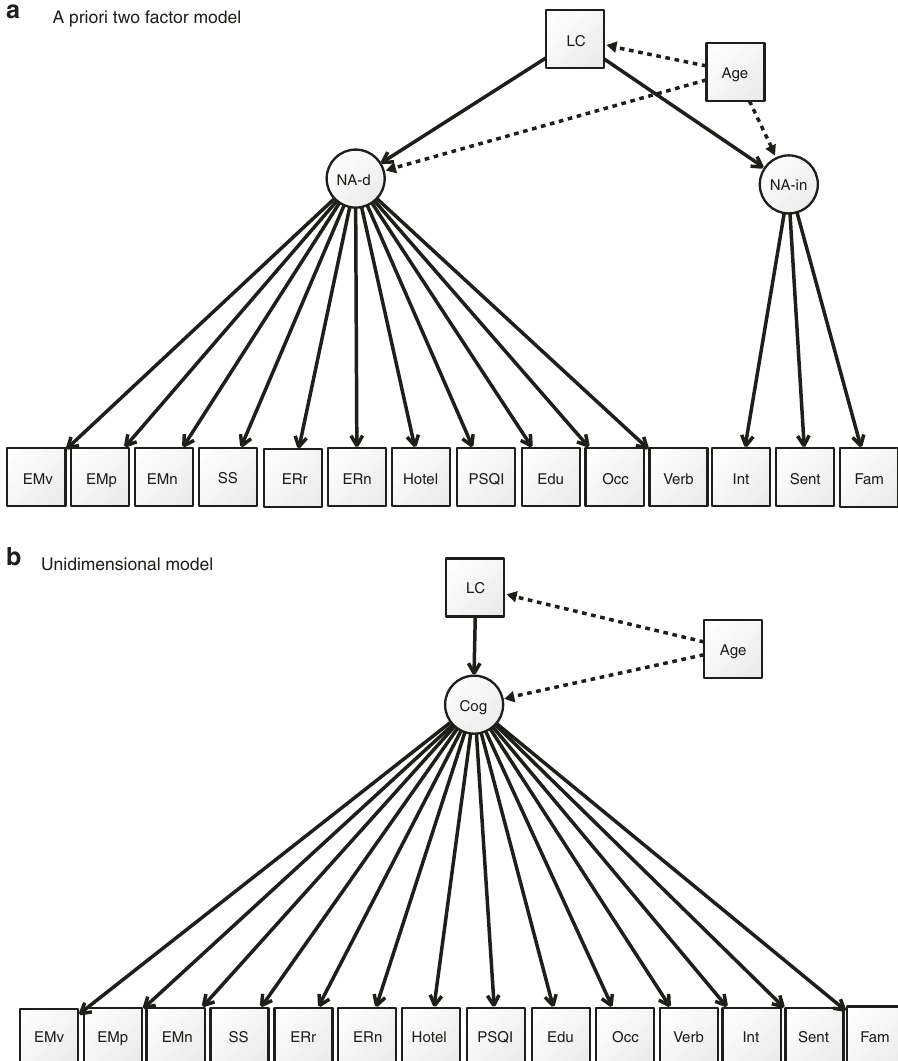
Fig. 1 The measurement models of LC-dependent function. LC mean normalized LC signal intensity (LC CR), NA-d NA-dependent factor, NA-in NA_independent factor, Cog single latent factor, EMv emotional source memory — negative valence, EMp emotional implicit memory (priming) — negative valence, EMn emotional object memory — negative valence, SS stop-signal response time (SSRT), ERr emotional reappraisal for negative emotion, ERn negative emotional reactivity, Hotel Hotel task total score, PSQI Pittsburgh Sleep Quality Index total score, Edu years of education, Occ occupational complexity, Verb Spot the Word test as a proxy for verbal intelligence, Int Cattell total score as a proxy for fl uid intelligence, Sent sentence comprehension, Fam familiar faces recognition.